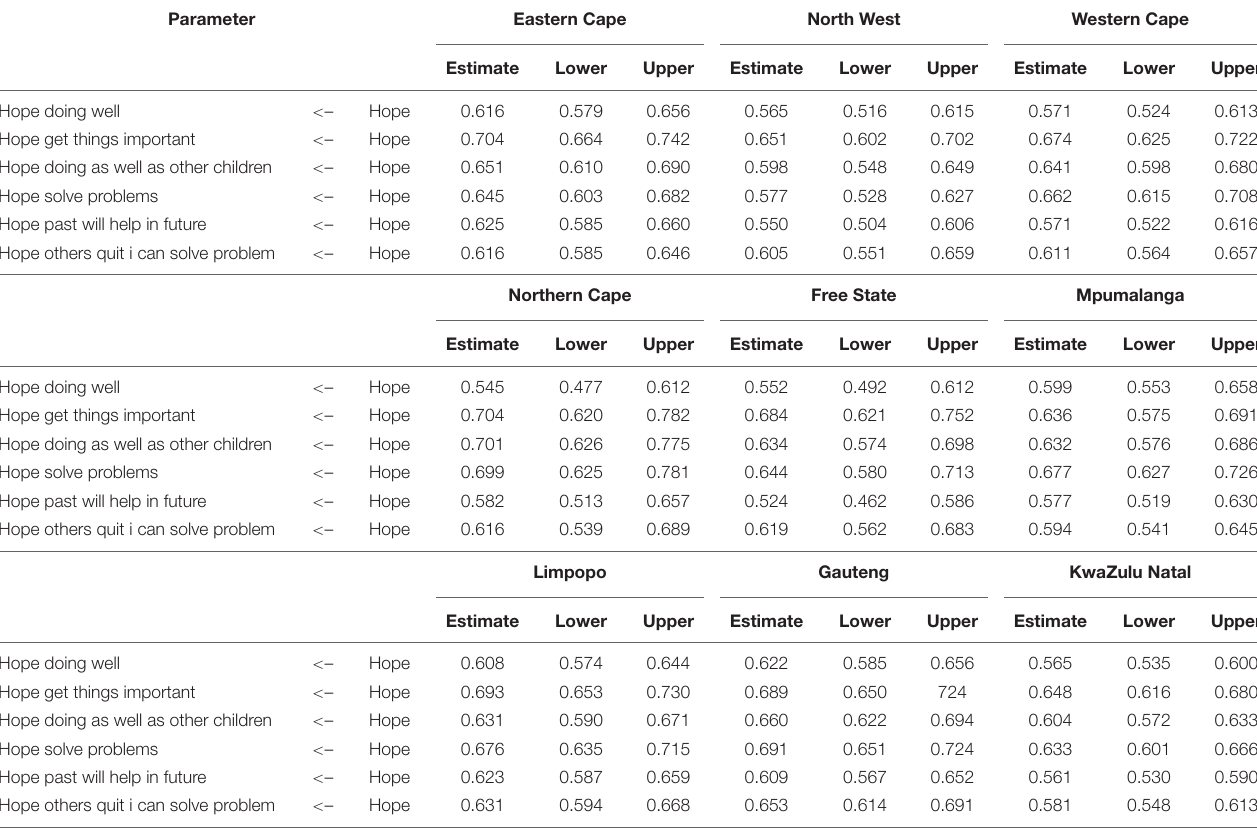
TABLE 2 | Standardized regression weights: (Provincial regions – constrained loadings and intercepts).